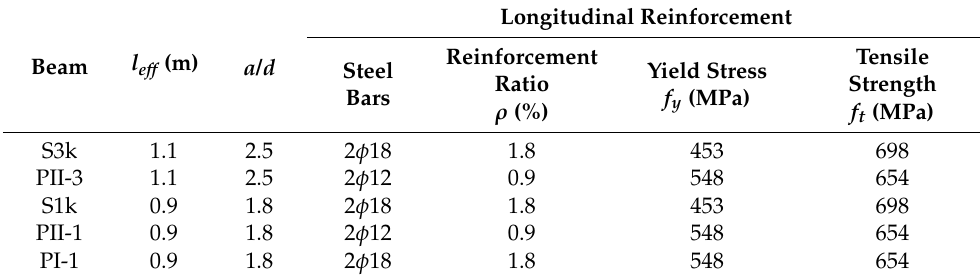
Table 3. Members considered in FEM